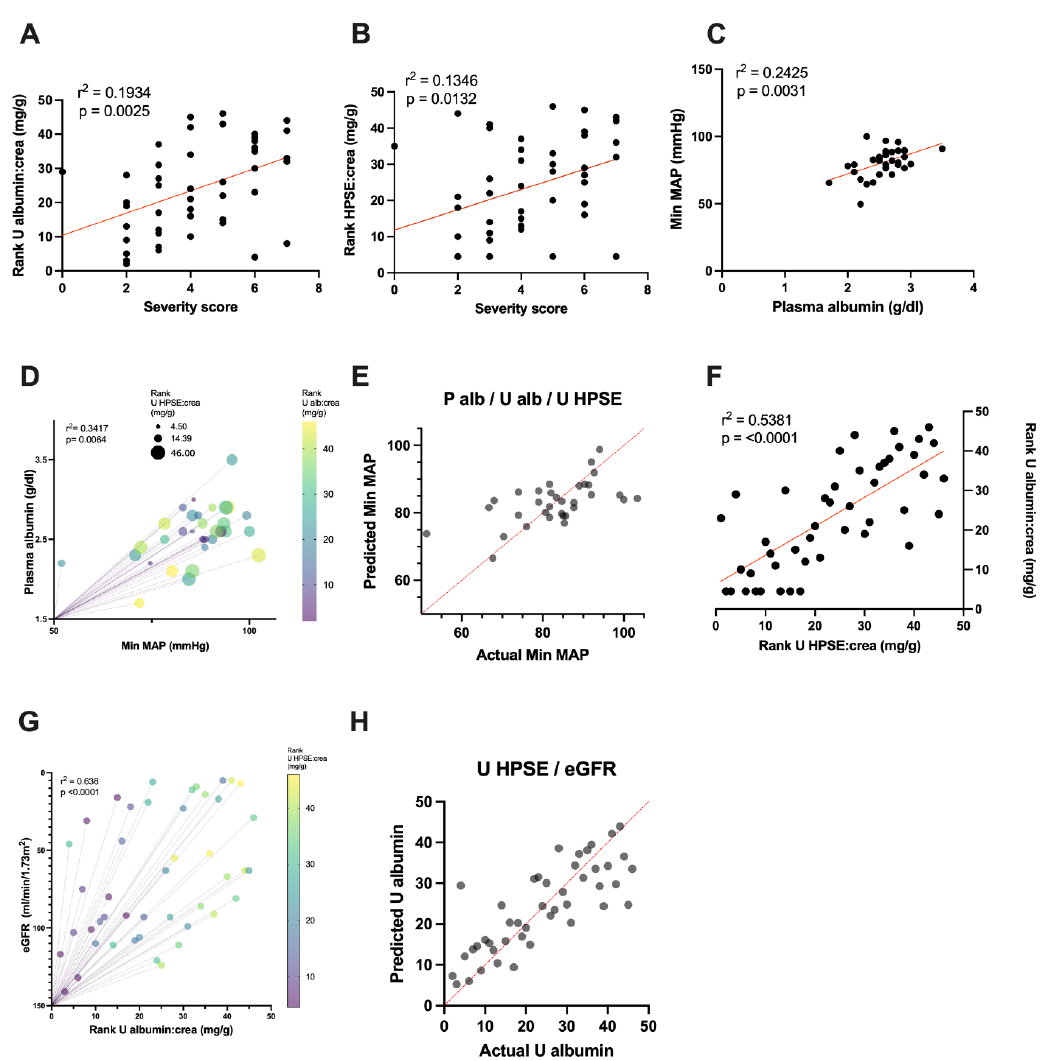
Figure 3. Simple and multiple linear regression models. Simple linear regression models of rank– transformed urinary albumin:creatinine ratio ( A ) and rank–transformed urinary HPSE:creatinine ratio ( B ) with severity score. ( C ) Simple linear regression model of plasma albumin and MAP. ( D ) Multiple linear regression model of plasma albumin, rank–transformed urinary HPSE:creatinine ratio and rank–transformed albumin on MAP. ( E ) Predicted vs. actual MAP of multiple linear regression model in D. ( F ) Simple linear regression model of rank–transformed urinary HPSE:creatinine ratio and albumin:creatinine ratio. ( G ) Multiple linear regression model of eGFR and urinary HPSE on albuminuria. ( H ) Predicted vs. actual data of the multiple regression model in G.